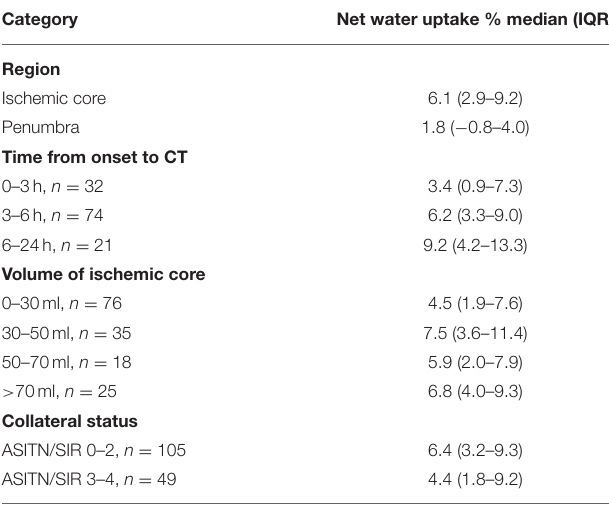
TABLE 1 | Net water uptake in different categories of lesion, infarct time, core volume, and collateral status. Category